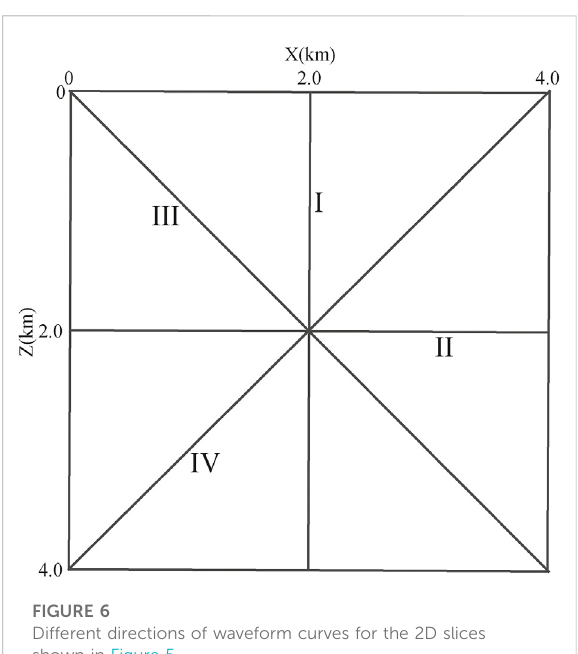
FIGURE 6 Different directions of waveform curves for the 2D slices shown in Figure